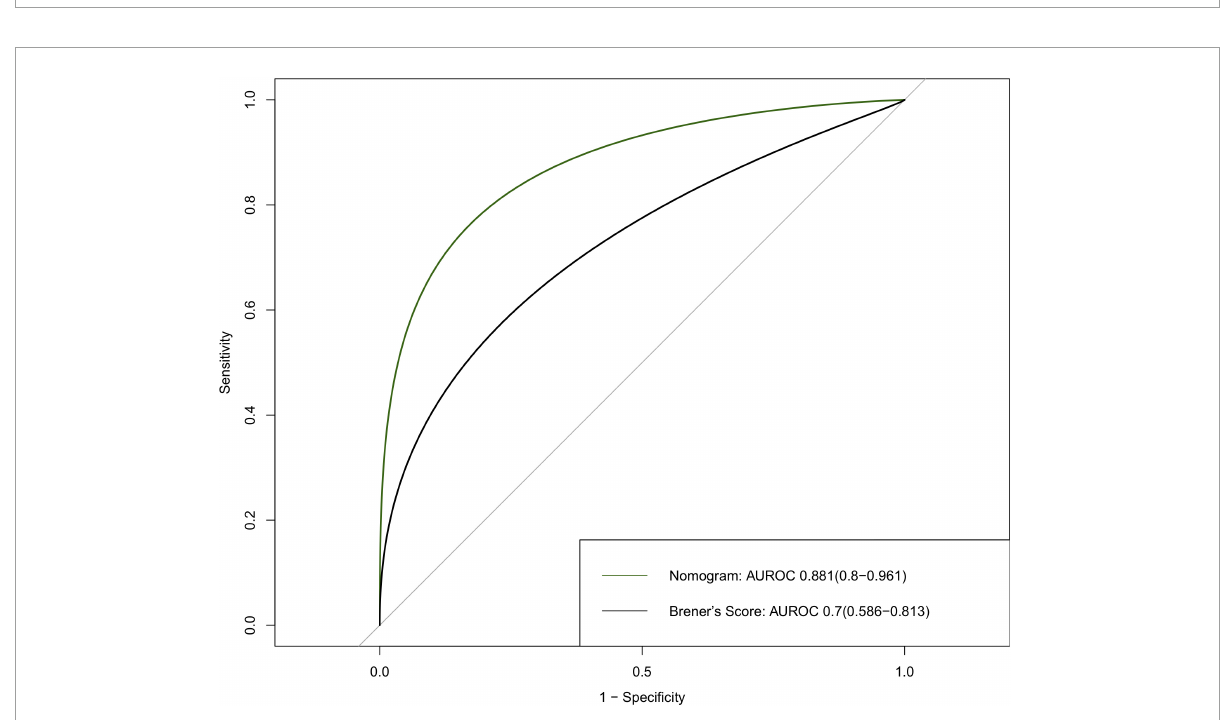
FIGURE5 Discrimination of the 30-day mortality of derivation cohort. ROC curves of the nomogram and Brener’s risk model predicting 30-day mortality with corresponding AUC values. ROC, receiver operating characteristic; AUC, area under